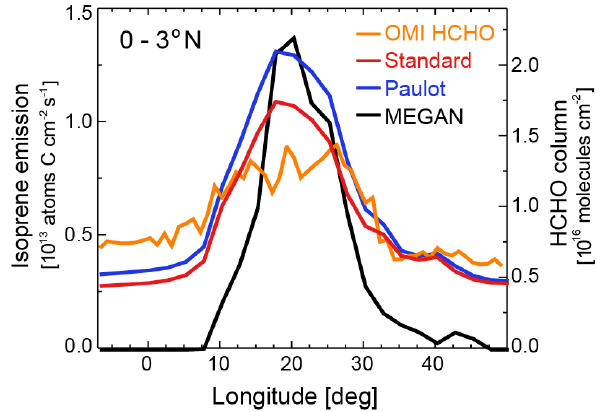
Fig. 8. Mean longitudinal gradients of isoprene emission (black) and HCHO columns (color) across central Africa (0–3 ◦ N) at 12:00–15:00LT in July. HCHO columns are shown for the OMI ob- servations in 2005–2009 (orange) and from the GEOS-Chem sim- ulations using the standard isoprene oxidation scheme (red) and the Paulot scheme (blue) in 2006. Isoprene emissions are from MEGAN. The HCHO columns have been filtered against biomass burning as described in the